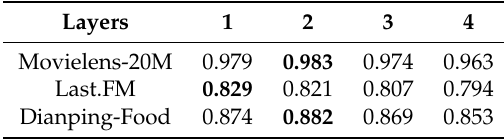
Table 7. Effect of different sampling layers on